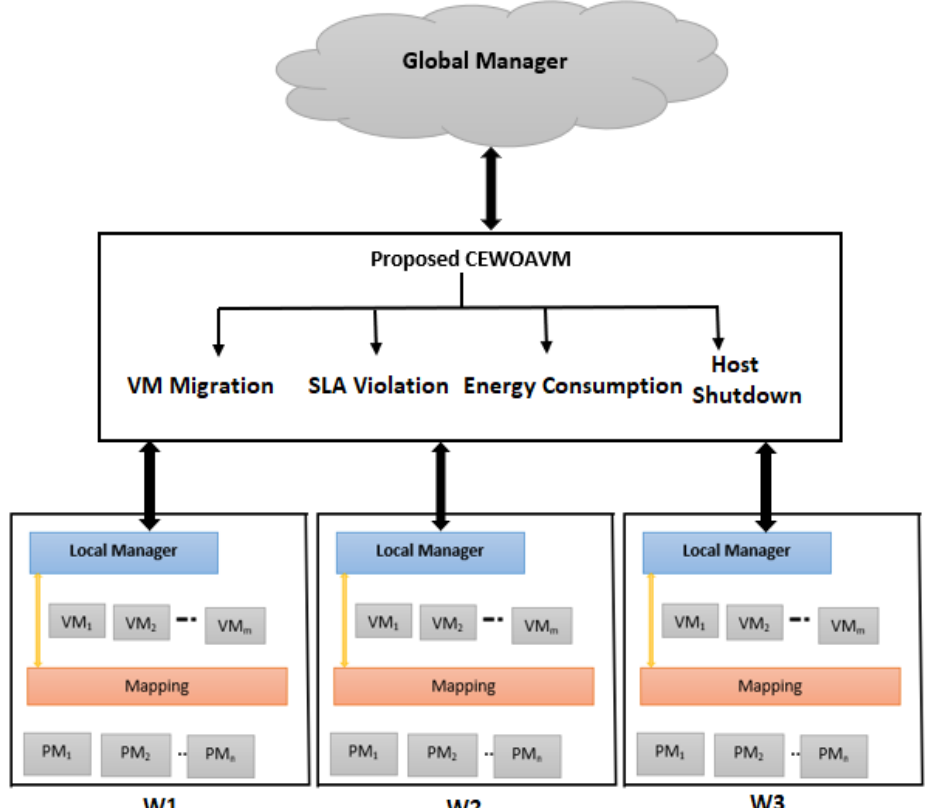
Figure 1. System architecture of VM